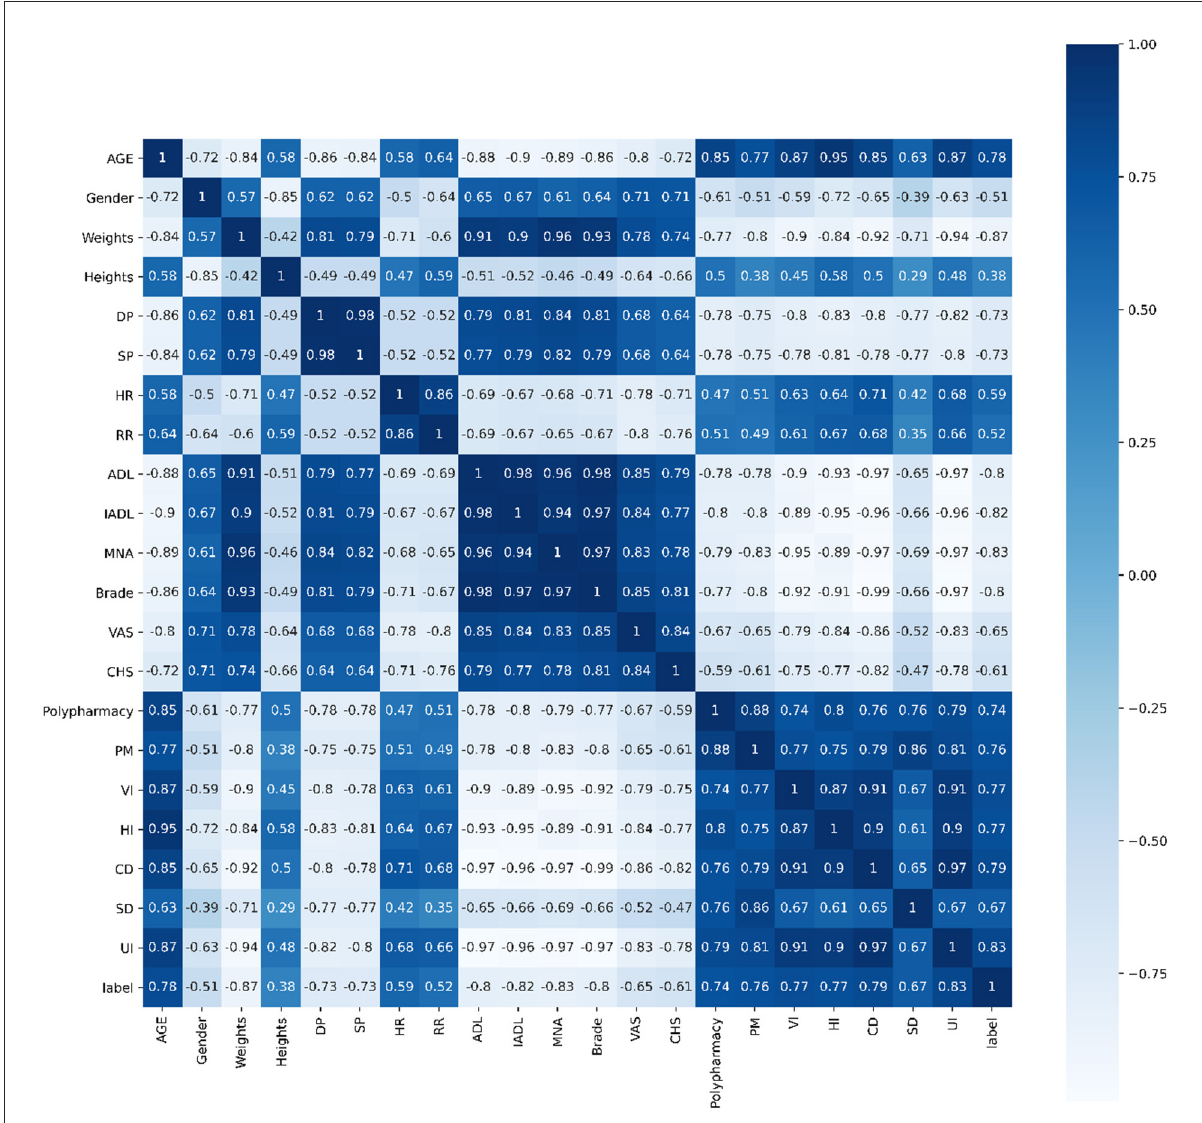
FIGURE10 Kendall’s correlation of all 21